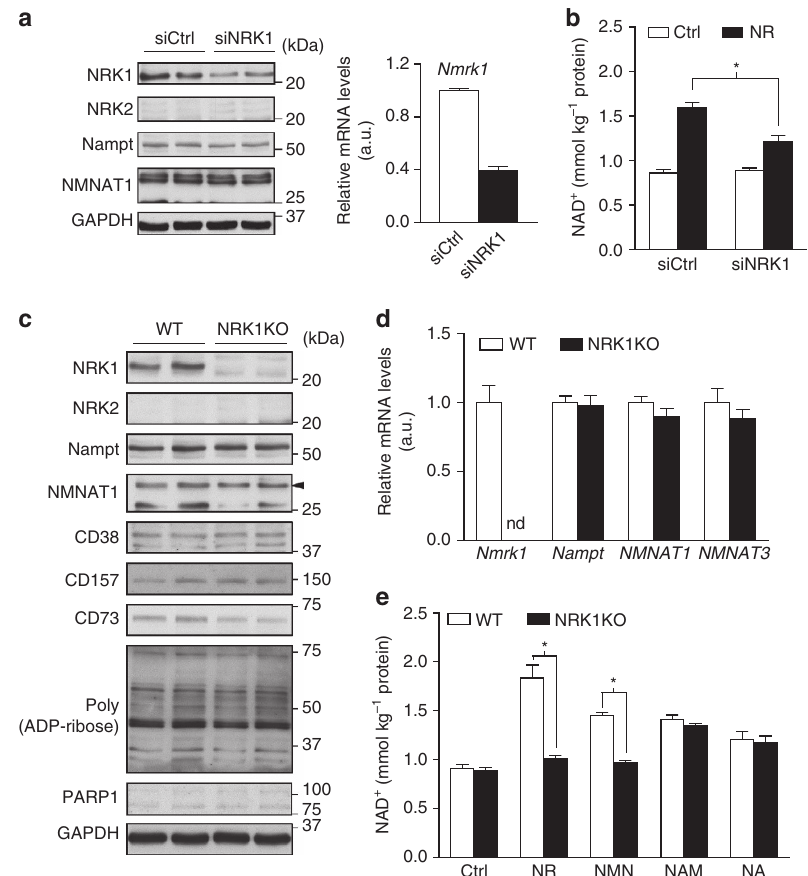
Figure 5 | NRK1 is essential for NR and NMN to enhance NAD þ synthesis in hepatic cells. ( a , b ) AML12 cells were transfected with NRK1 siRNA. ( a ) Protein and mRNA levels of NRK1 and other NAD þ -related enzymes. ( b ) NAD þ measurement after 6h 0.5mM NR treatment. * P o 0.05 versus ctrl by two-sided unpaired T-test. ( c – e ) Primary hepatocytes were isolated from 10 to 15 weeks old WT and NRK1KO male mice. Protein ( c ) and mRNA ( d ) levels of NRK1 and other enzymes involved in NAD þ metabolism. ( e ) NAD þ measurement after 6h treatment with 0.5mM NR, 0.5mM NMN, 5mM NAM, 0.5mM NA or vehicle control. Results shown are mean ± s.e.m., * P o 0.05 versus WT by two-sided unpaired T -test. ( n ¼